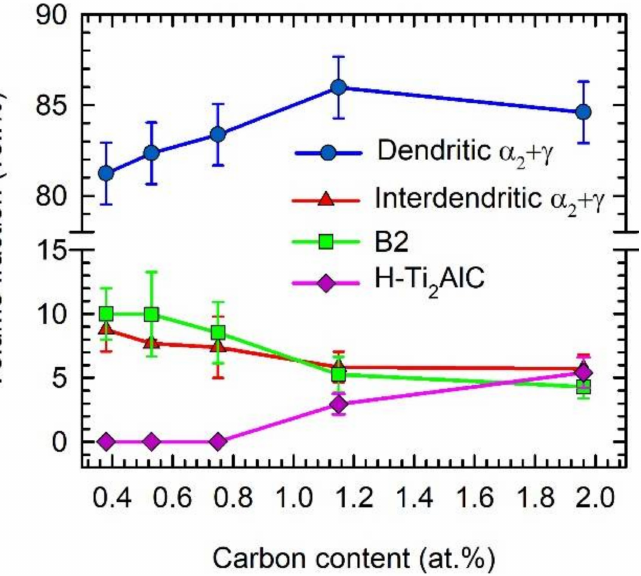
Figure 7. Dependence of the volume fraction of individual phases and microstructural regions on carbon